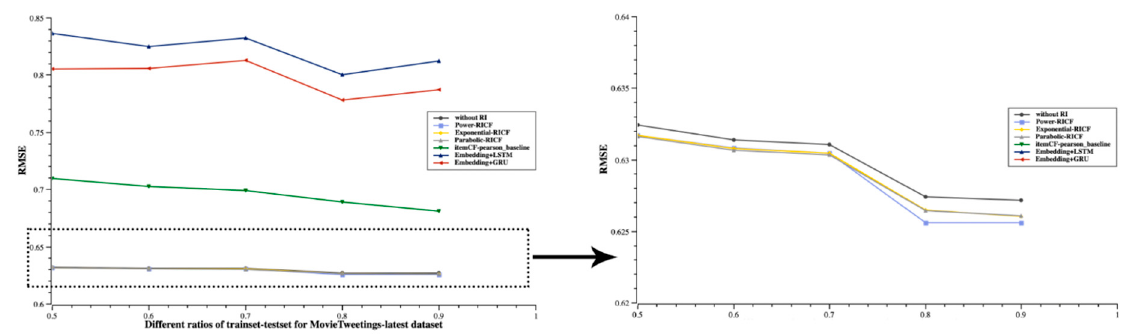
Figure 13. RMSE of seven algorithms on the MovieTweetings-latest dataset.